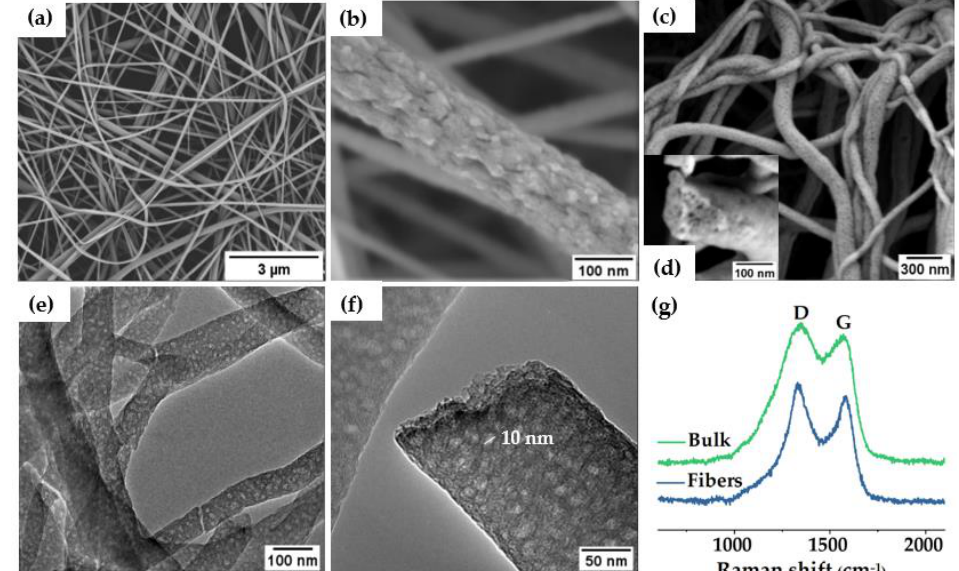
Figure 2. ( a ) Scheme of disordered morphology of PS − b − PAN upon uncontrolled phase-separation, ( b ) SEM image of bulk material after carbonization, ( c ) TEM image of bulk carbon material.